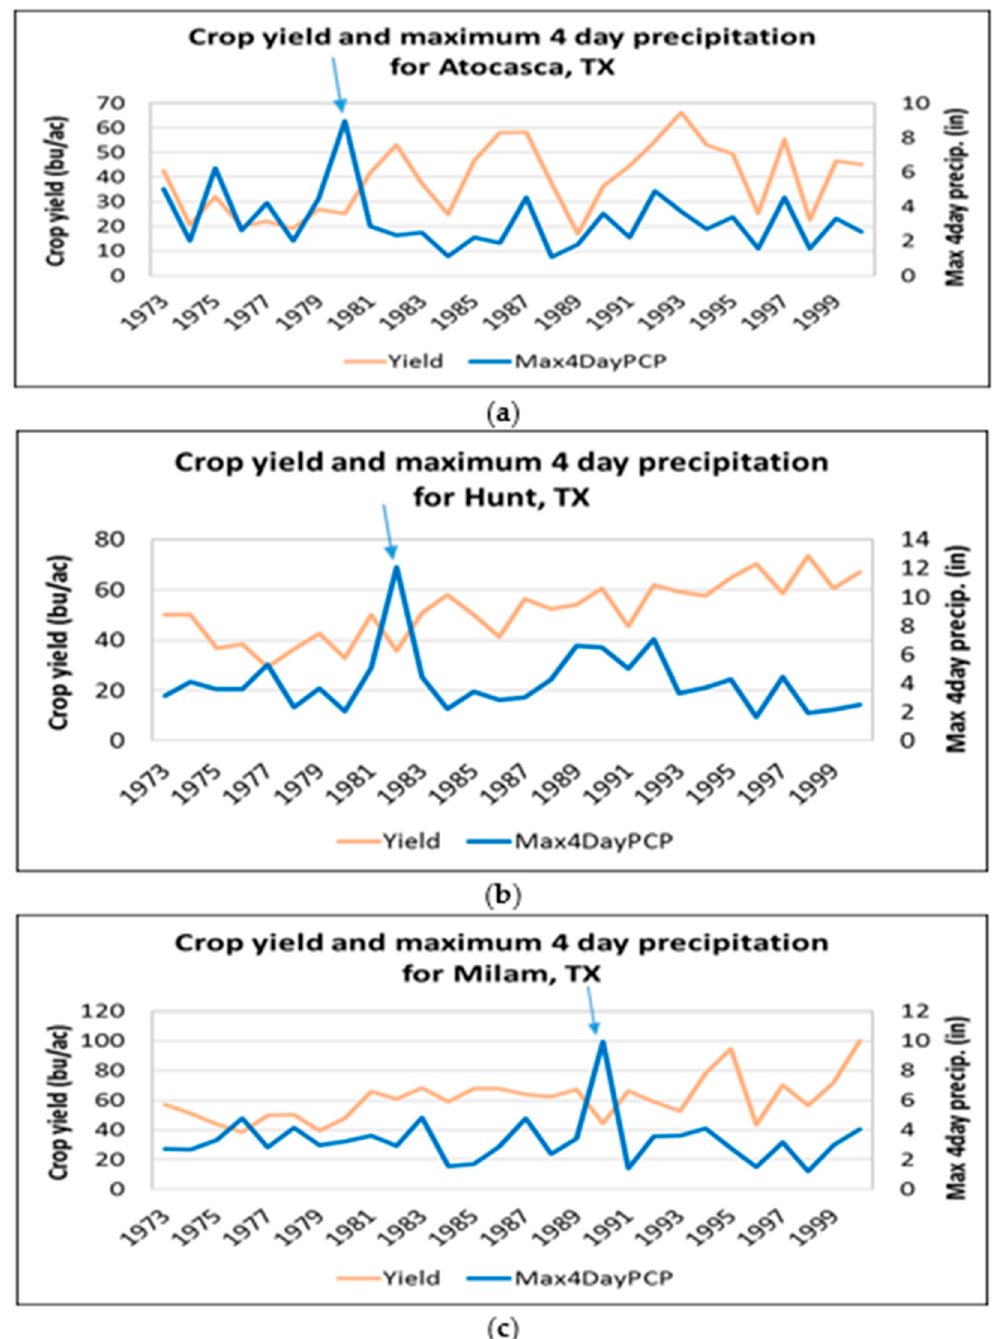
Figure 9. Relationship between maximum 4-day total precipitation and rainfed sorghum yield for ( a ) Atascosa ( b ) Hunt, and ( c ) Milam counties. Atascosa ( b ) Hunt, and ( c ) Milam